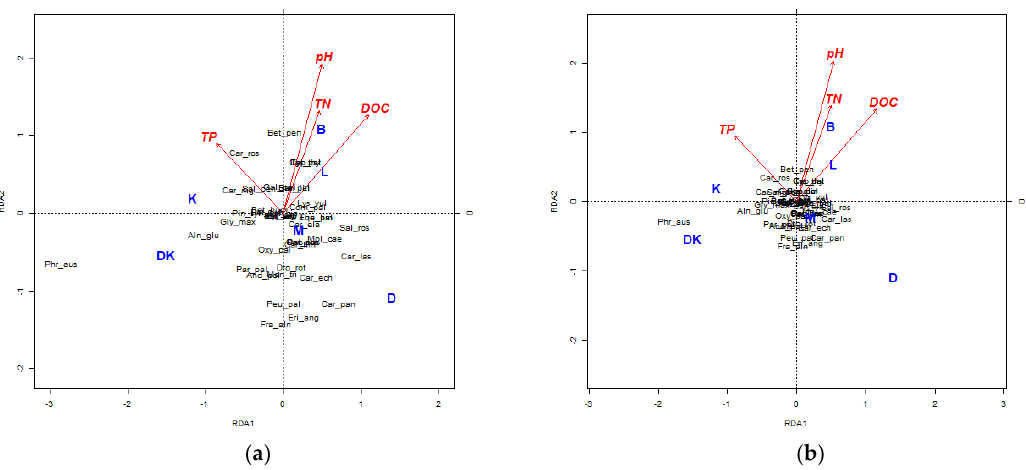
Figure 8. Ordination triplots of the first two axes (RDA1 and RDA2) generated from the redundancy analysis for six study sites, 43 species, and four environmental variables. ( a ) scaling = 1; ( b ) scaling = 2.